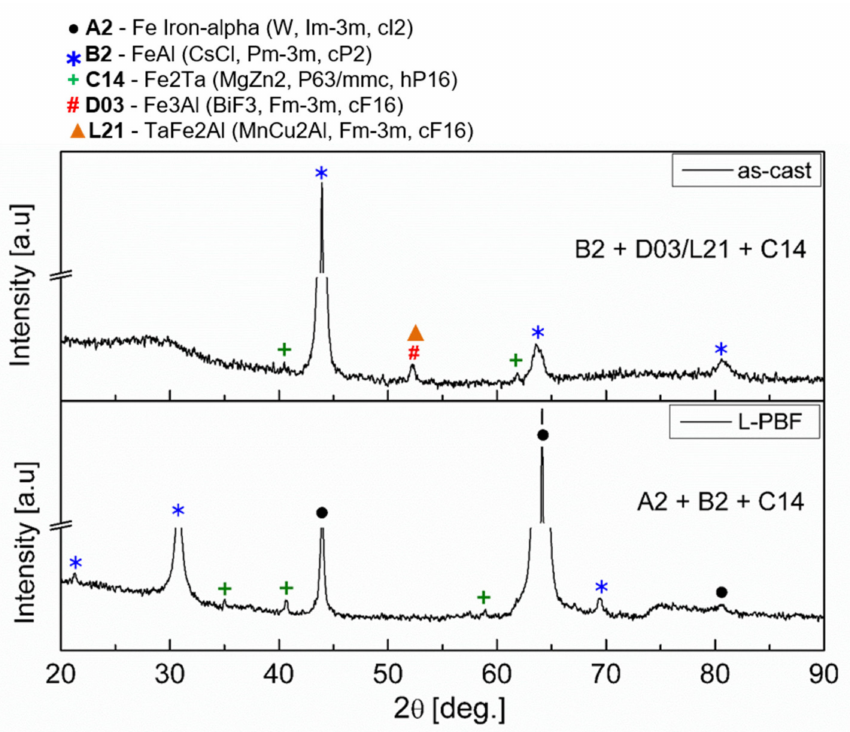
Figure 3. Room-temperature XRD diffraction patterns of the Fe-25Al-1.5Ta samples produced by L-PBF and centrifugal investment casting using Cu-K α 1